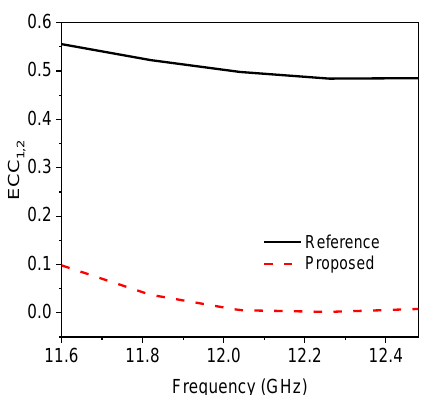
Figure 9. ECC values (calculated from far-field data).